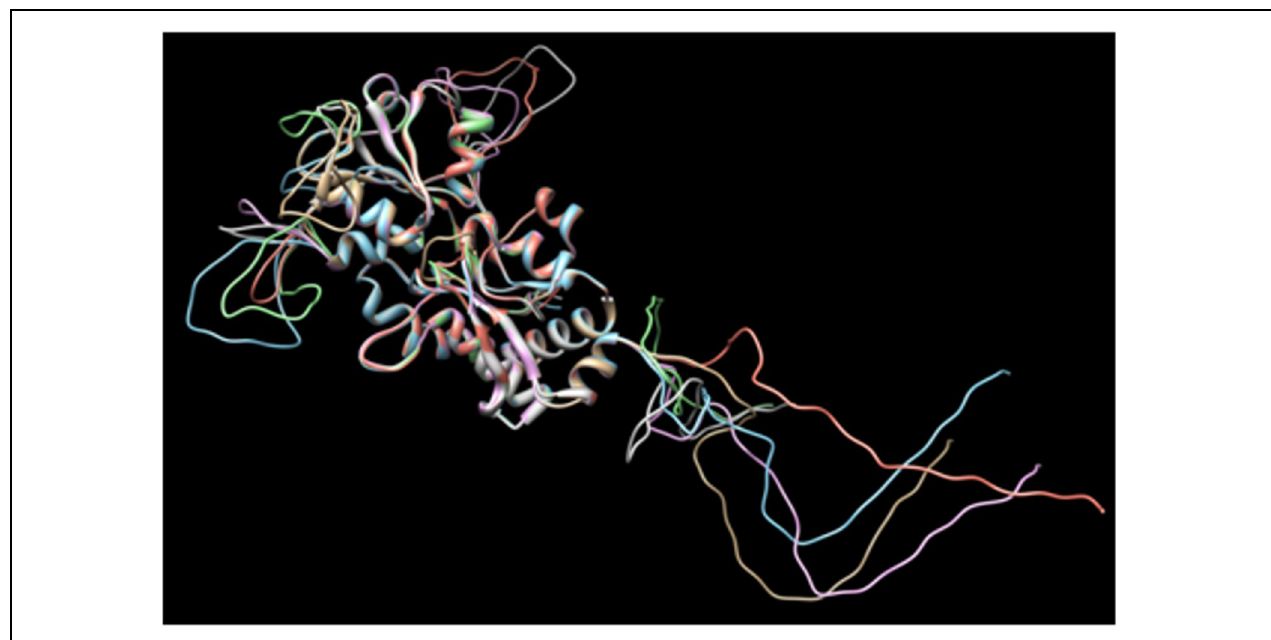
FIGURE 2 | Dimensional structures of each of the proposed amino acid sequences of CjaA with the three insertions of CjaD peptide epitopes.